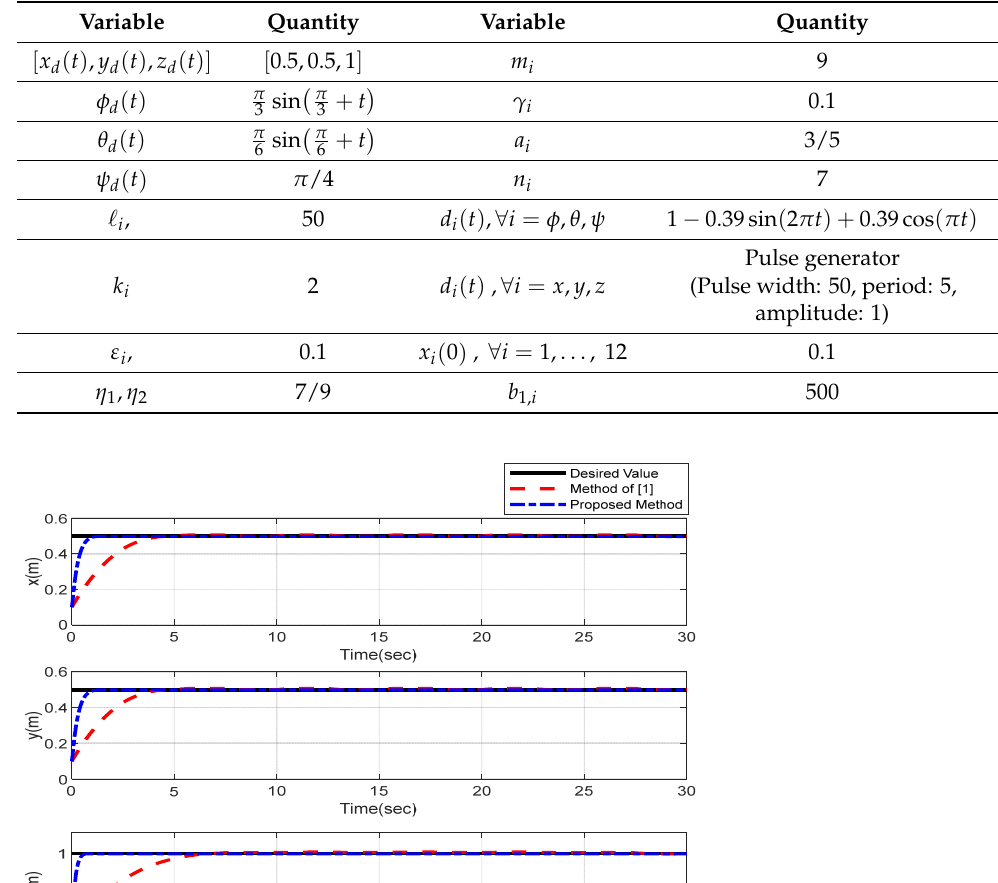
Table 3. Parameters of the control strategy, ∀ i = x , y , z , φ , θ , ψ .